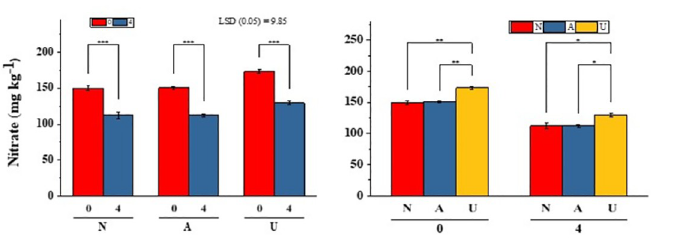
Fig 5. Nitrate concentration in 4% bentonite clay mixed sandy soil after discrete incubation with Ca(NO 3 ) 2 (N), NH